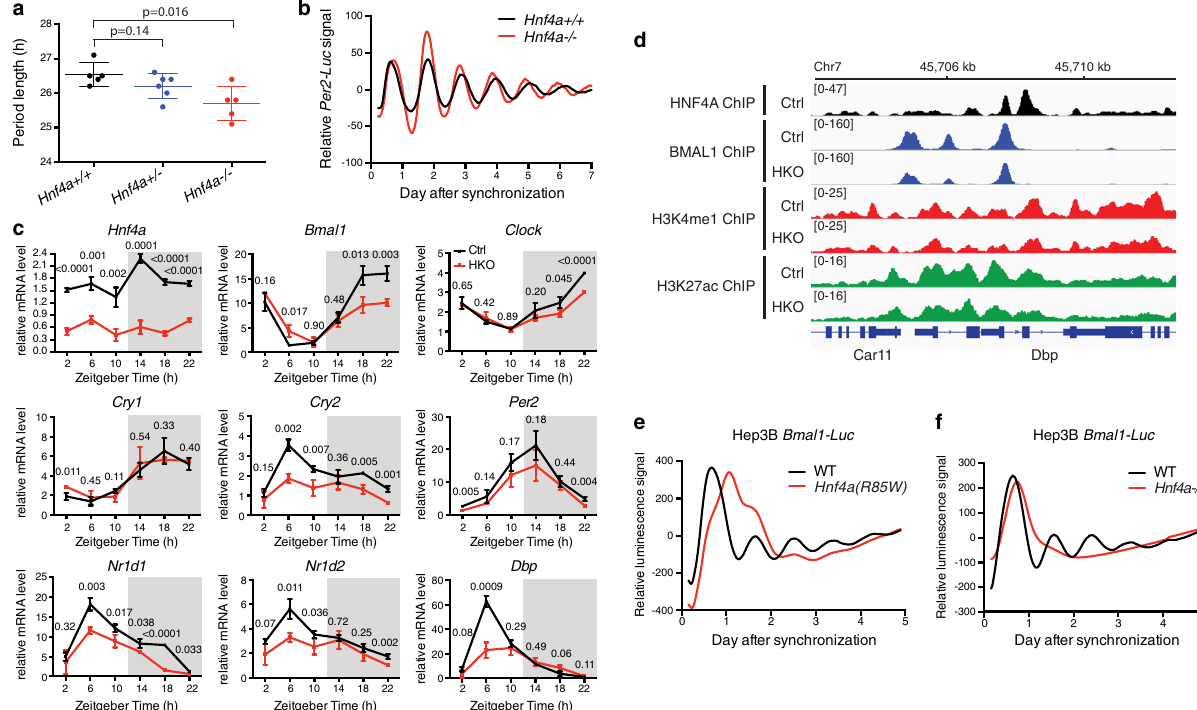
Fig. 4 Circadian rhythms are disturbed by Hnf4a knockout and HNF4A-MODY mutation. a , b Liver tissue explants were isolated from mice of indicated genotypes and recorded for Per2-Luc bioluminescence. Period lengths of Per2-Luc oscillation were plotted (means ± SD, n = 5 or 6) and